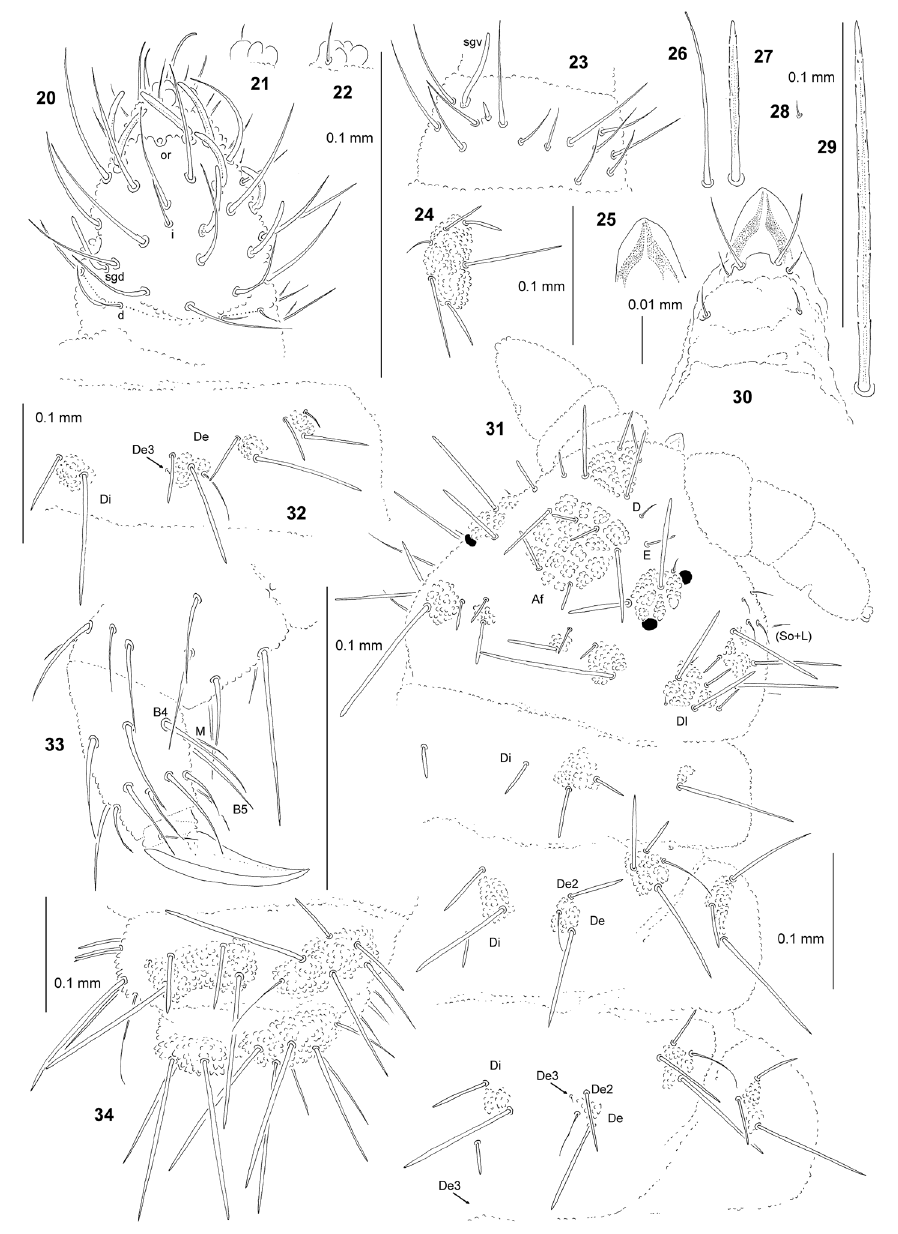
Figures 20–34. Endonura turkmenica sp. n.: 20 dorsal chaetotaxy of Ant III–IV 21 apical bulb, ventral view 22 apical bulb, dorsal view 23 ventral chaetotaxy of Ant III 24 tubercle L of Abd IV 25 ventral sclerifications of labrum 26 sensillum of Abd V 27 chaeta Di2 of Abd V 28 chaeta Di3 of Abd V 29 chaeta Di1 of Abd V 30 chaetotaxy of labrum 31 chaetotaxy of head and Th (holotype), dorsolateral view 32 chaetotaxy of Abd II 33 leg II, chaetotaxy of T and Fe, lateral view 34 chaetotaxy of Abd V–VI, dorsolateral